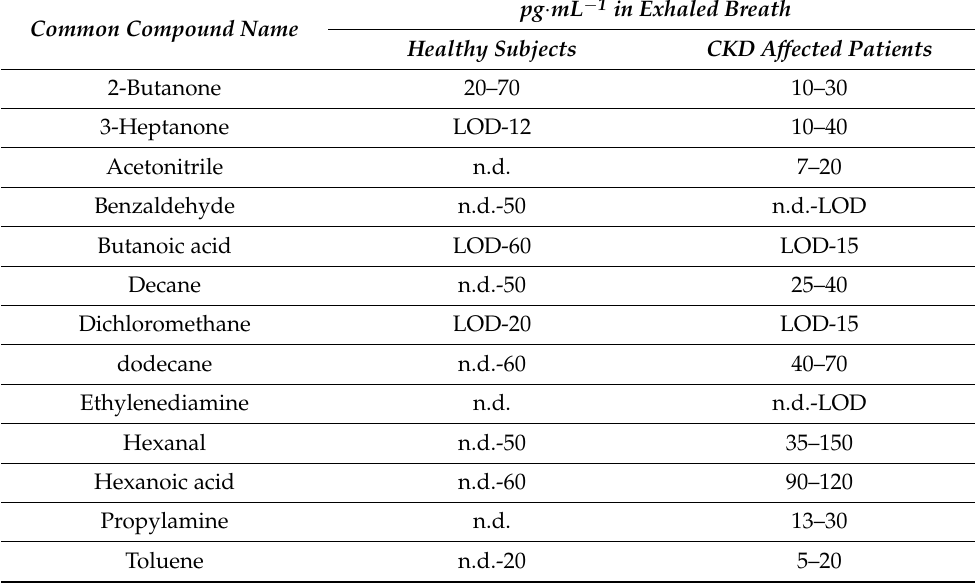
Table 7. The concentration range of the thirteen selected VOCs identified in the exhaled breath samples for both healthy subjects and/or CKD-affected patient